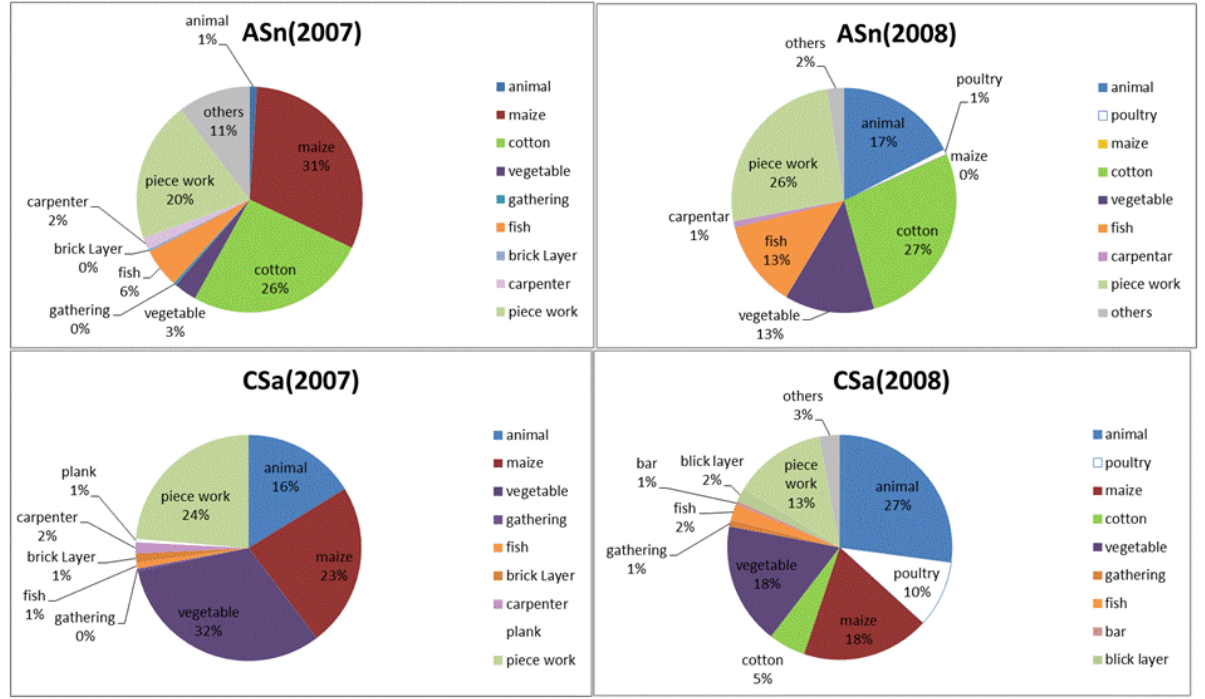
Fig.4 comparison of cash obtaining ways before/after heavy rainfall shock at ASn and